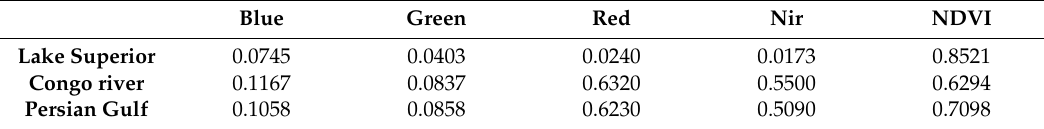
Table 5. Comparison of the results for the coe ffi cients of extraction using di ff erent methods.